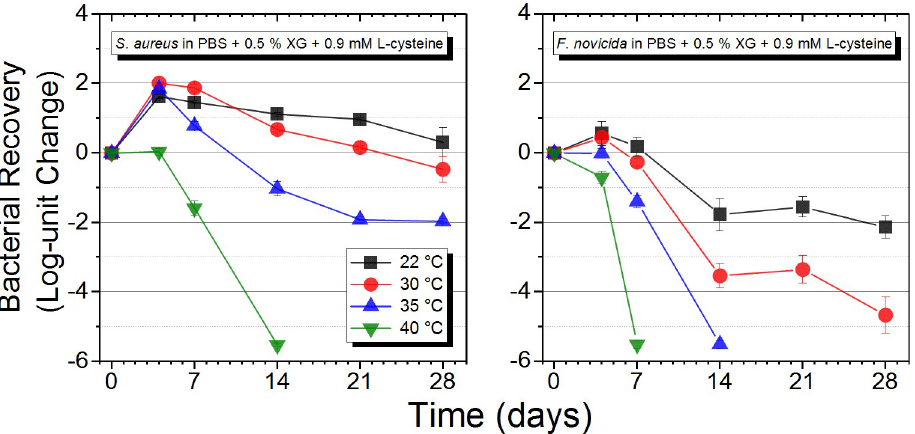
Fig 4. Role of temperature on S . aureus and F . novicida viability over time. Test matrices were spiked with ~10 5 CFU/mL of S . aureus or F . novicida and incubated at 22–40˚C for 28 days. Viable plate counts were conducted at various time points to determine cell stability. Data are the average of three biological replicates and three sample replicates plated in triplicate (n = 9 measurements).